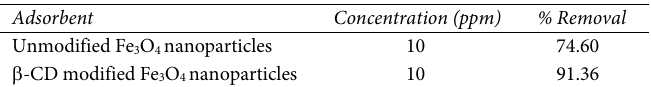
Table. 3. Comparison of removal efficiency of As(III) by the (a) naked and (b)